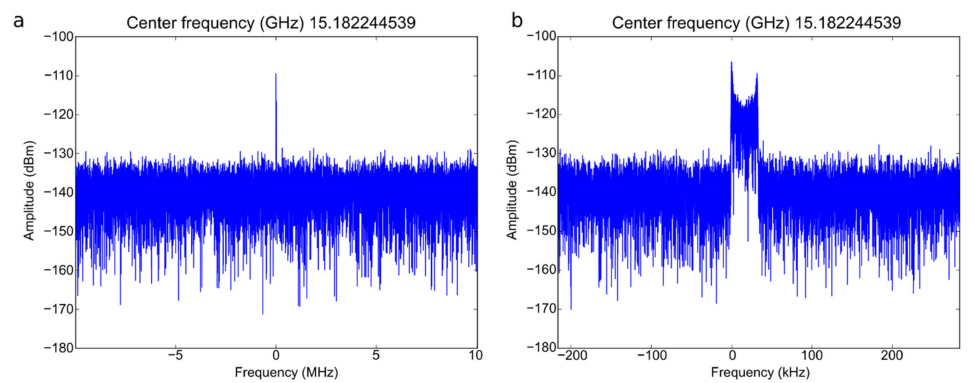
Figure 3. Observation on the spectrum analyzer of a single intemodal beatnote (IBN) for a 580-mA driving current and 23.3 Ω device resistance: ( a ) Span = 20 MHz, RBW = 100 Hz; ( b ) Span = 20 MHz, RBW = 50 Hz. RBW: Resolution bandwidth.